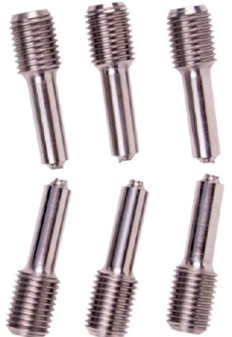
Figure 7. Notched tensile test specimens.